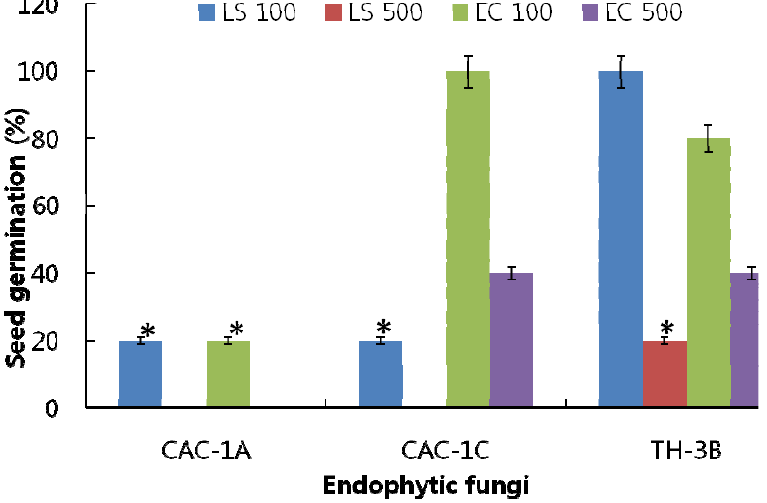
Figure 2. The effect of ethyl acetate extract of three fungal strains on the germination of Lactuca sativa (LS with 100 and 500 ppm) and Echinochloa crus - galli (EC with 100 and 500 ppm) seeds. The ‘*’ indicates that values are significantly different ( p < 0.05). The error bars represents ± SD ( n =